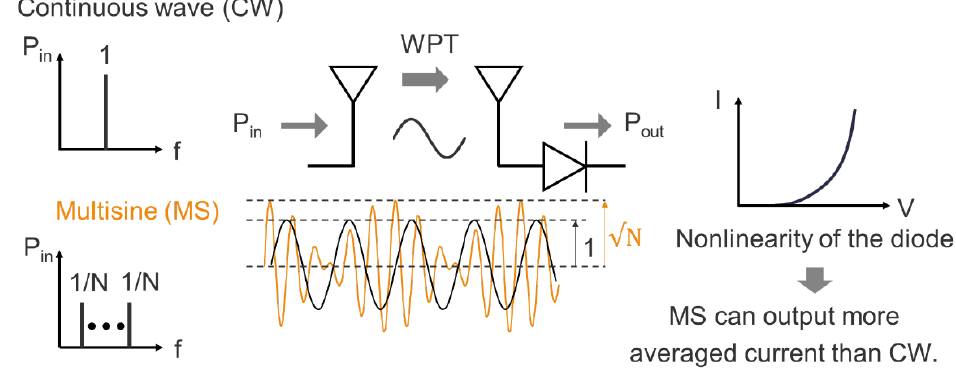
Figure 1. Efficiency improvement in wireless power transfer with multisine electromagnetic waves.